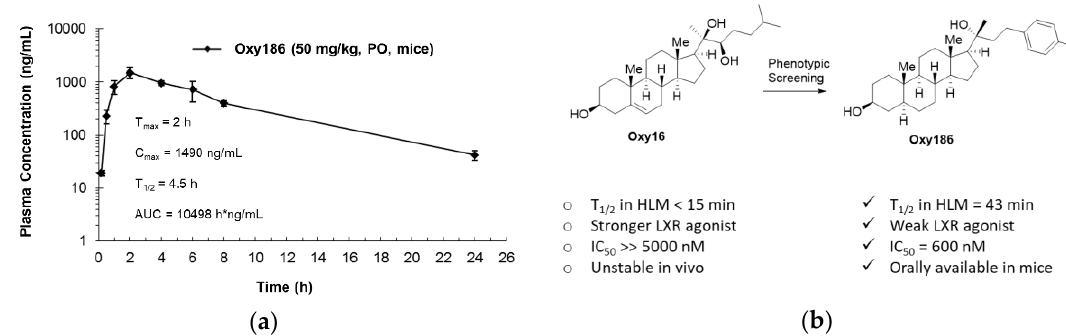
Figure 8. Drug-like properties of Oxy186. ( a ) A single dose of Oxy186 at 50 mg / kg, formulated in 4% ethanol / 15% DMSO / 81% corn oil, was administered to balb / c mice by oral gavage. Plasma samples were taken at 10 min, 30 min, 1, 2, 4, 6, 8, and 24 h, followed by LC / MS analysis of the plasma. ( b ) Evolution of Oxy186 from parent compound Oxy16 and their drug-like properties. Table 1. Metabolic stability in human and mouse liver microsomes (HLM and MLM, respectively). HLM, % Remaining HLM, MLM, % Remaining MLM, Compound 1 after 60 min Half-Life after 60 min